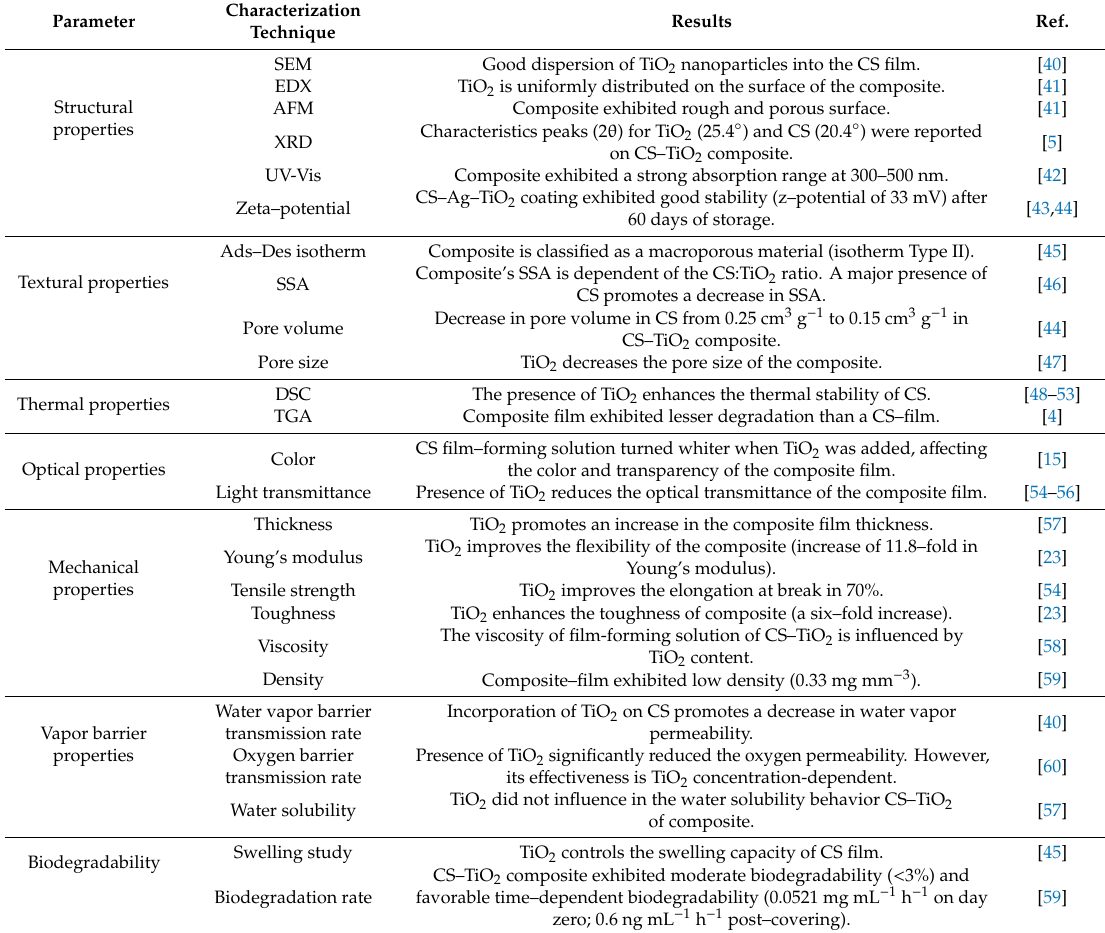
Table 2. E ff ect of TiO 2 incorporation on chitosan (CS) matrix